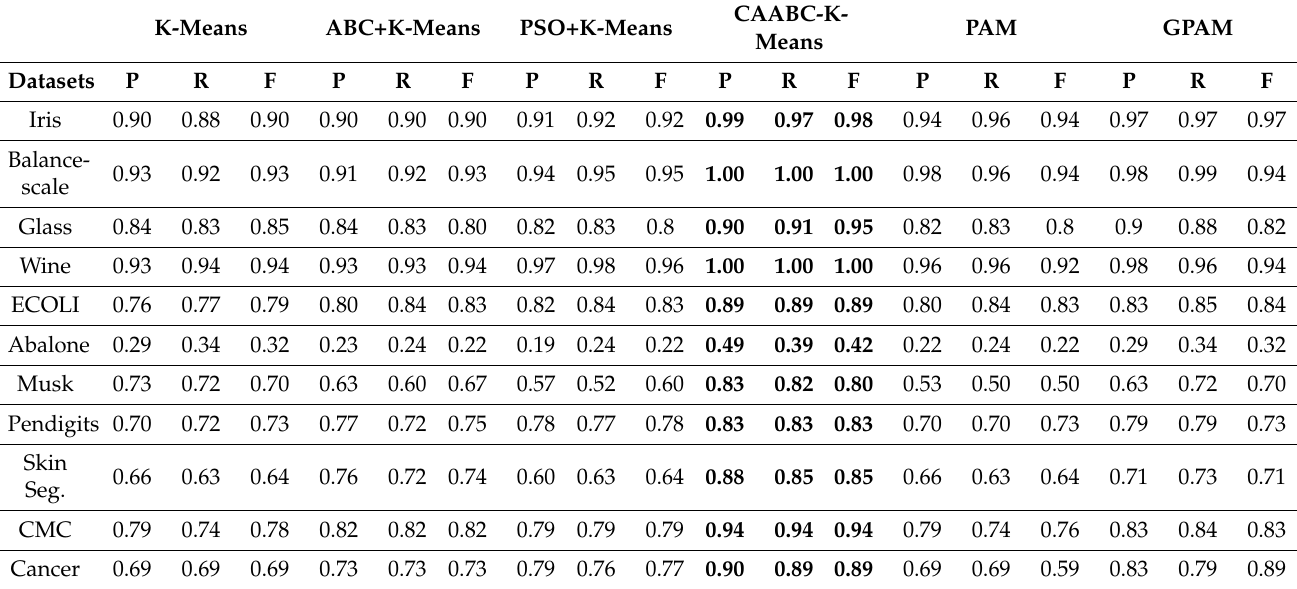
Table 9. The f-score of the training